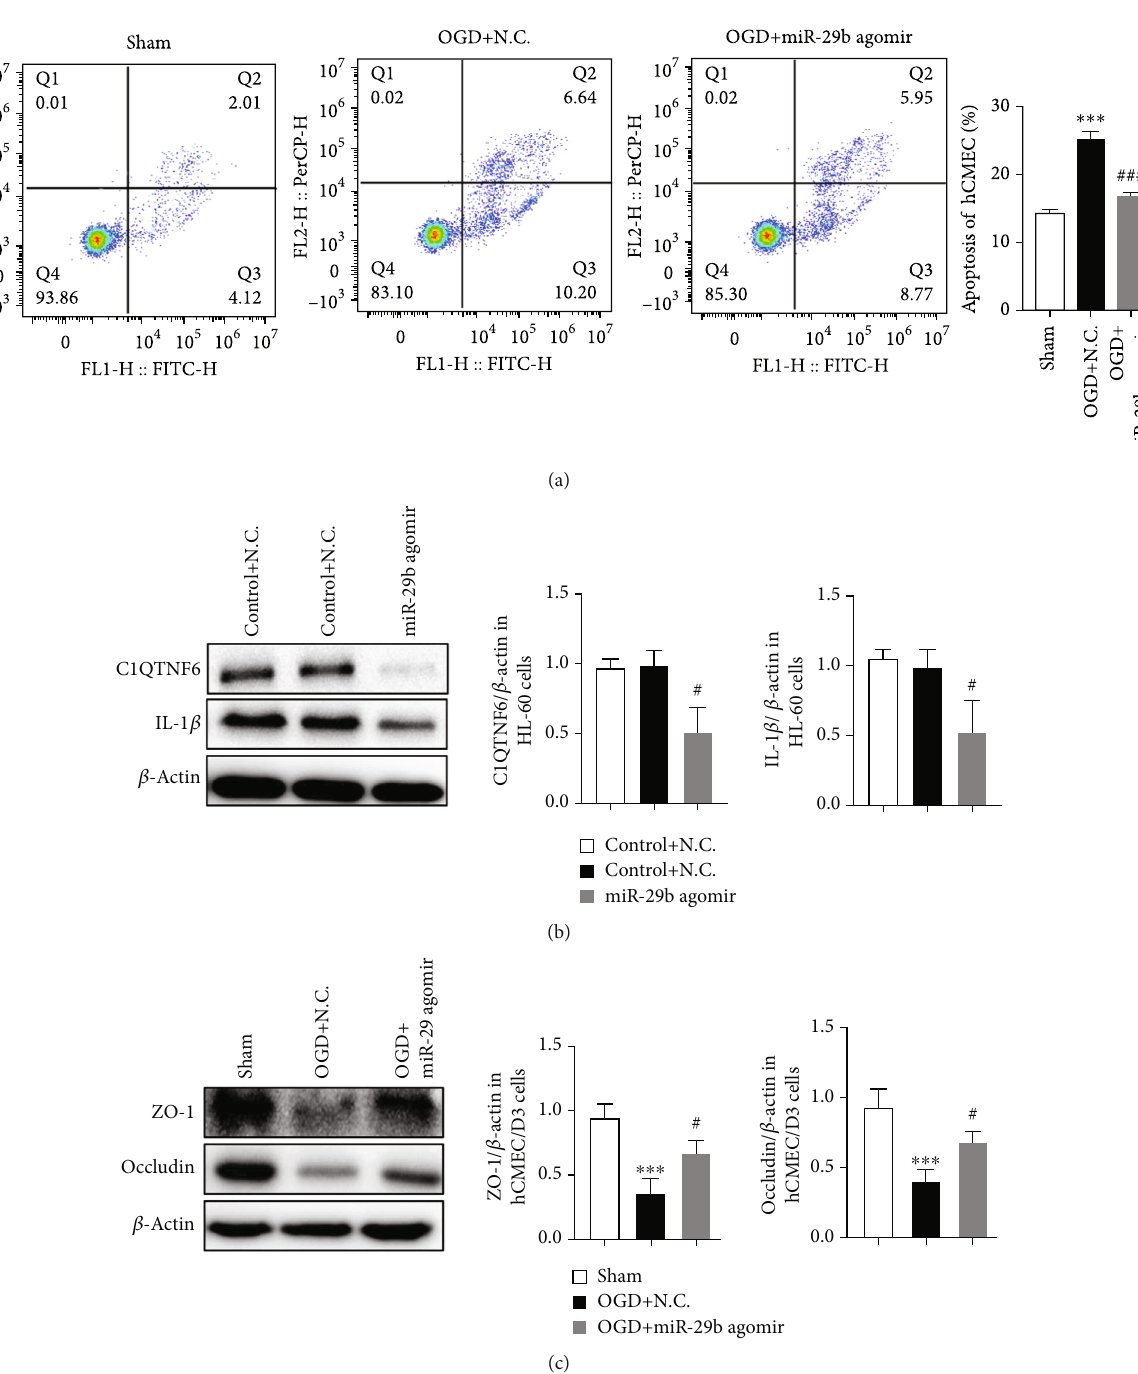
Figure 6: miR-29b in leukocytes regulates zonula occludens- (ZO-) 1 and occludin protein expression in oxygen – glucose deprivation (OGD) hCMEC/D3 cells. (a) Apoptosis rate of hCMEC/D3 cells cocultured with HL-60 cells treated with either miR-29b agomir or control agent. N = 6 . (b) Protein expression of C1QTNF6 and IL-1 β in the HL-60 cells assessed by Western blot. N = 6 . (c) Protein levels of ZO-1 and occludin in hCMEC/D3 cells measured by Western blot. N = 6 . ∗∗∗ P < 0 : 001 vs. sham group; # P < 0 : 05 vs. OGD group; ### P < 0 : 001 vs. OGD+NC